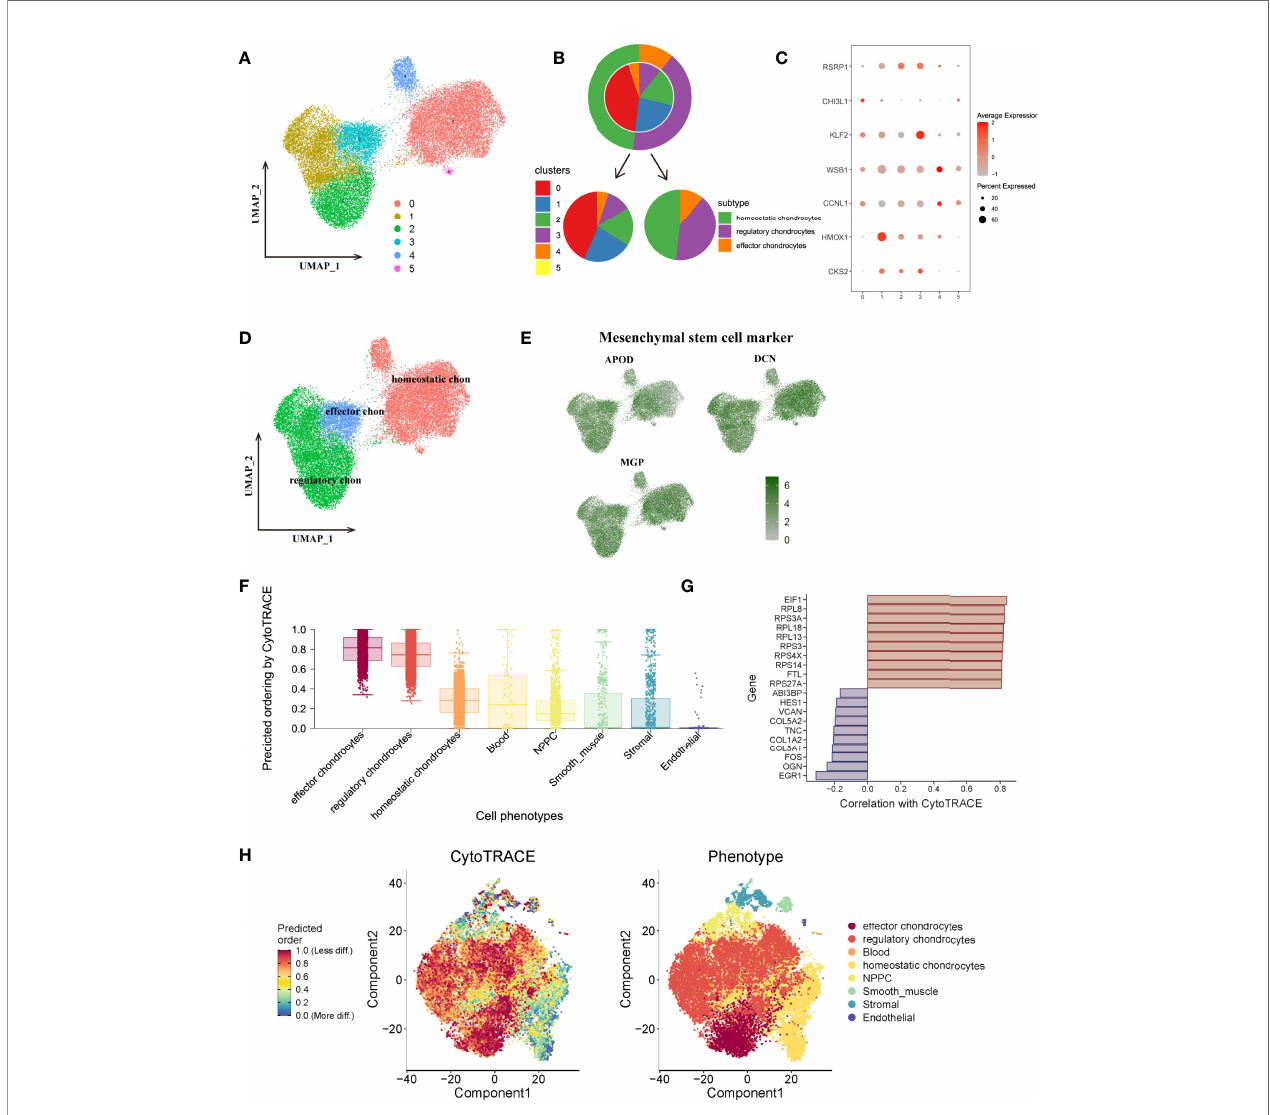
FIGURE 6 | (A) , UMAP plot of chondrocytes subtypes, which were extracted from the whole cells and applied for re-UMAP analysis. (B) , Sector proportion diagram of chondrocytes before and after cell type annotations. (C) , Dot plot displayed the mean expression of selected marker genes among different clusters. (D) , UMAP plot after cell type annotation for each cluster. (E) , the average expression of mesenchymal stem cell markers for chondrocytes on the tSNE map. (F) , Plot of the cytoTRACE pseudotime order for the CEP subpopulations. The value of each cell type in cytoTRACE represented the predicted order. (G) , The top 10 correlated genes in the overall cell type differentiation. (H) , Overall tSNE plot for each cell based on cytoTRACE algorithm, blue dots represented low differentiated state while red dots represented high differentiated state for